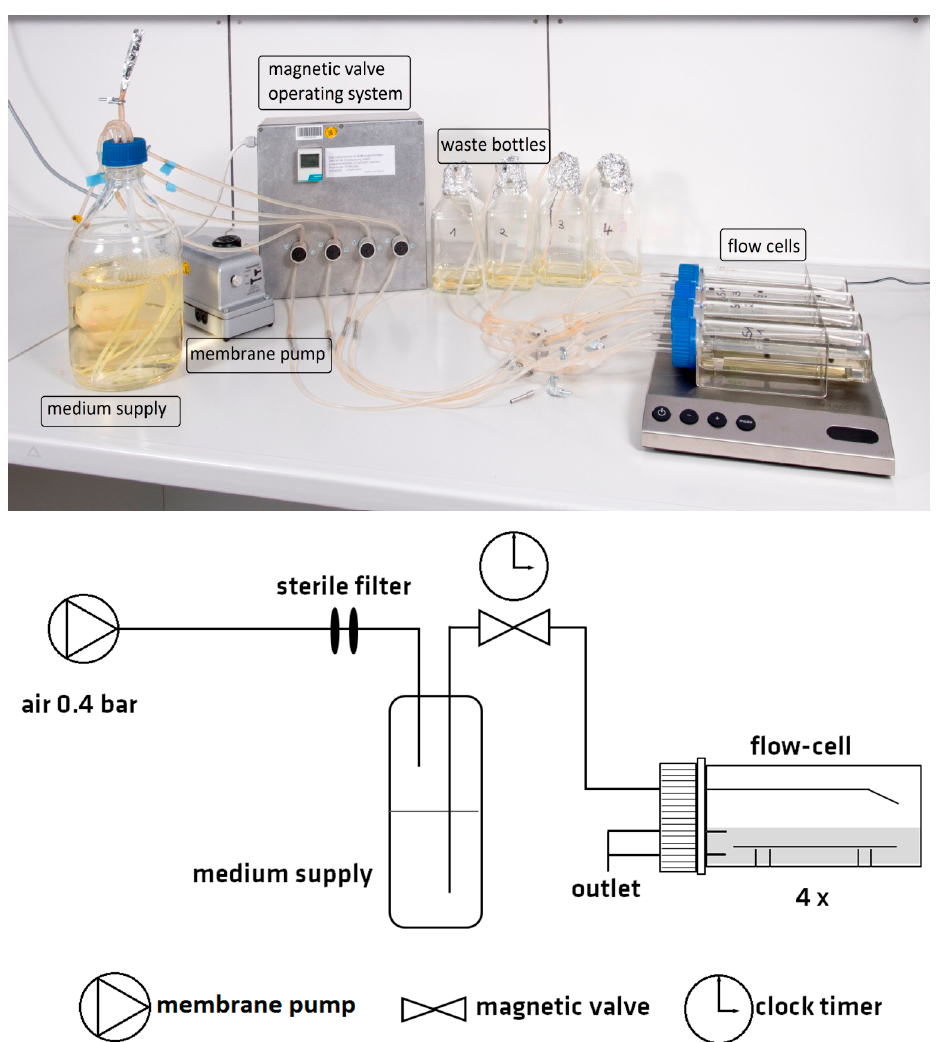
Figure 1. Experimental setup of the flow chamber system. A membrane pump generates an air pressure in the medium supply container and fresh medium is supplied by controlled opening and closing of the magnetic valves. A flow rate of 16 mL·h − 1 (open valves for 3 s every 15 min) was applied in the described experiments.